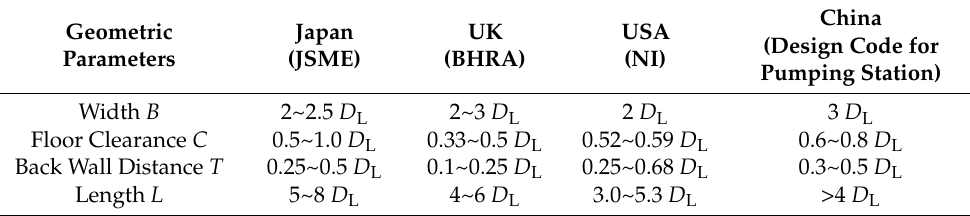
Table 2. Recommended geometric parameters of the open sump in different countries.